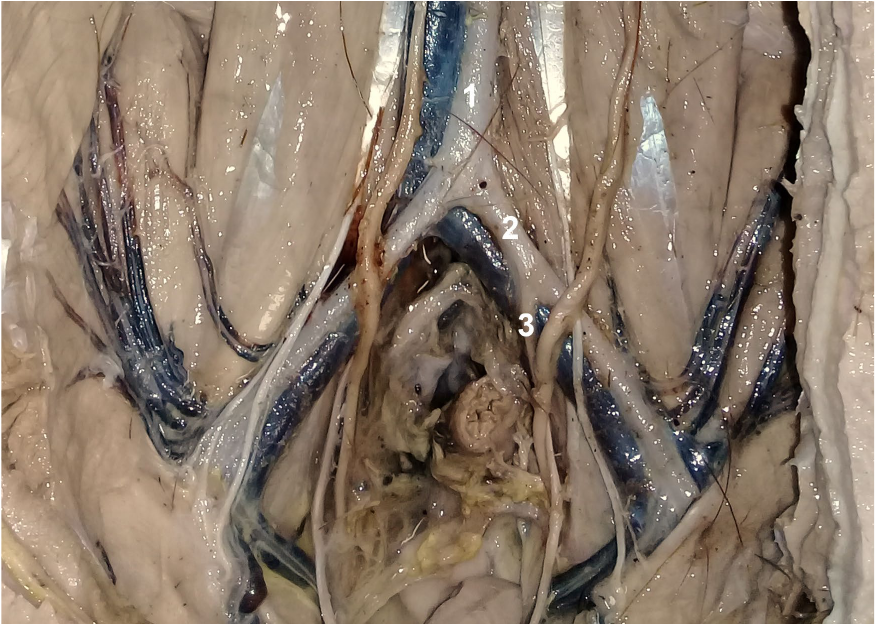
Figure 8. Topographic region of pelvis. Viscera removed to show vascular distribution: 1. Aorta; 2. common iliac; 3. internal iliac, that will branch to become the uterine artery.